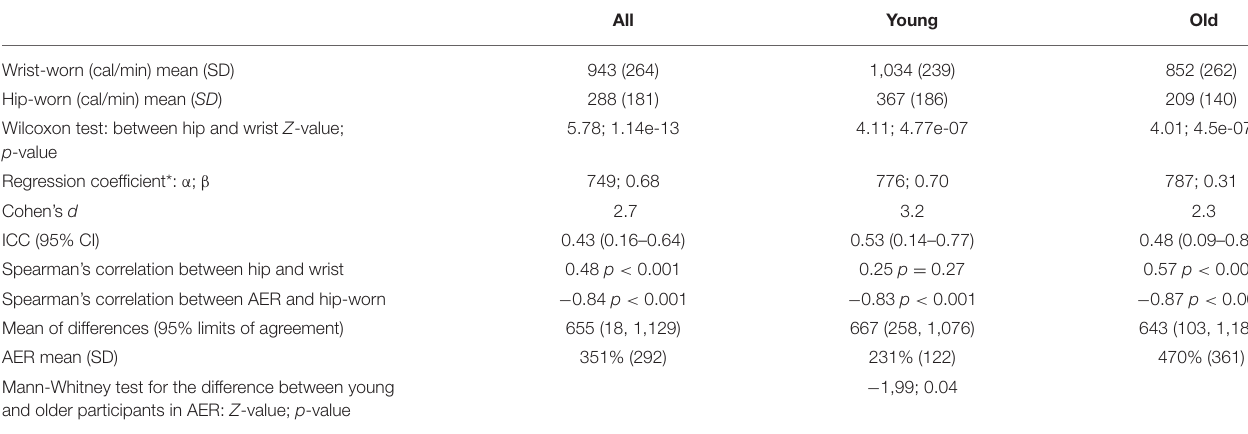
TABLE 1 | AEE Descriptive statistics, comparison, correlation, agreement, and Bland-Altman parameters for the Active energy expenditure (AEE) provided by the wrist-worn and hip-worn AT for all participants and by age